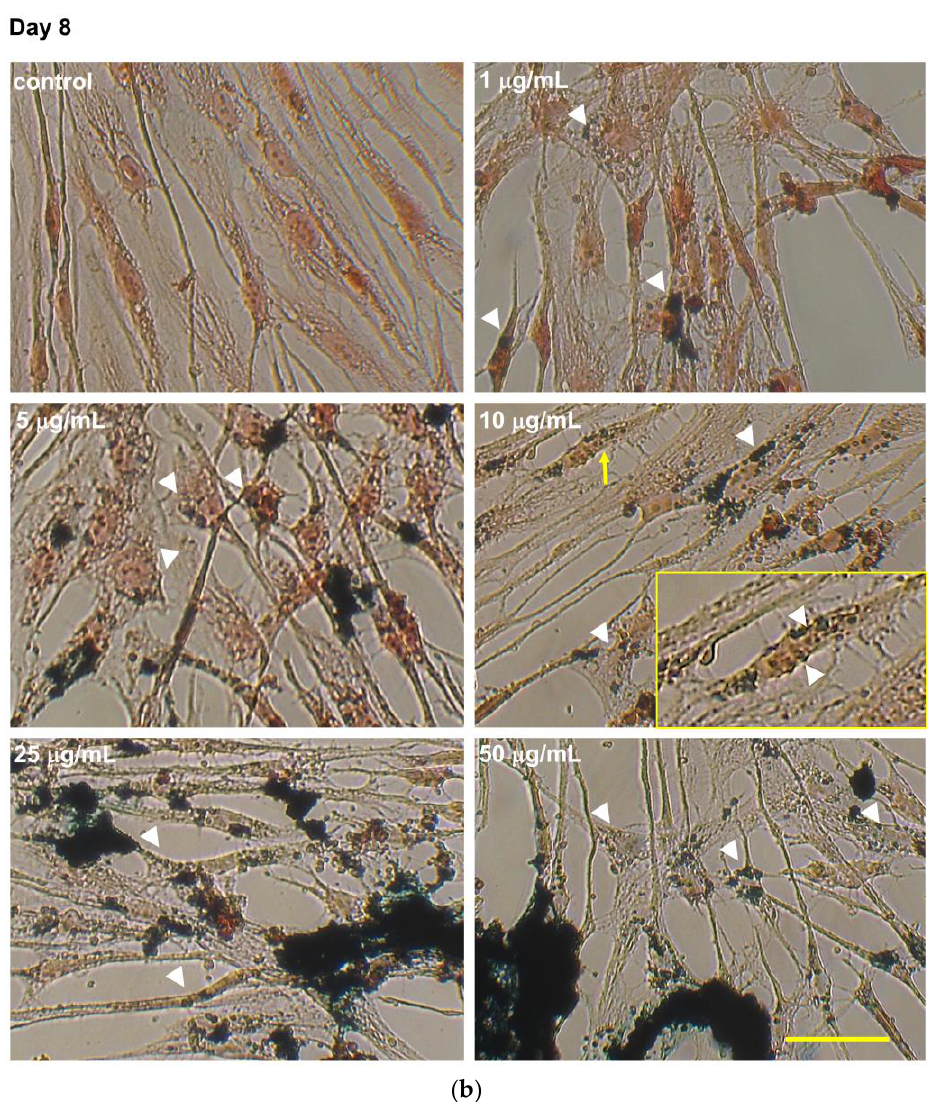
Figure 4. Intracellular evaluation of Fe 3 O 4 NPs by Perls’ Prussian blue staining in hNLCs cultured with Fe 3 O 4 NPs. Representative micrographs, by light microscopy, of hNLCs after 3 days ( a ) and 8 days ( b ) in neurogenic medium with increasing concentrations of Fe 3 O 4 NPs (1–50 µ g / mL). Prussian blue staining showed fine intracellular blue spots of Fe 3 O 4 NPs around the nucleus already at the lowest concentration tested (1 µ g / mL). The intracellular iron accumulation increased with increasing concentration and the aggregations / agglomerations of Fe 3 O 4 NPs were also visible extracellularly. White heads indicate intracellular nanoparticles and yellow arrows indicate the magnifications (2X) of the areas of the insert selection. Scale bar: 100 µ m.